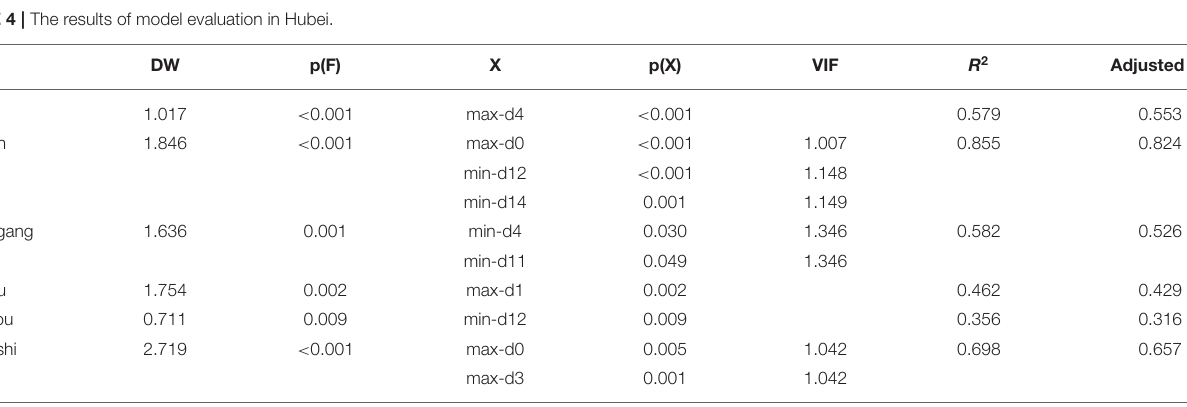
TABLE 4 | The results of model evaluation in